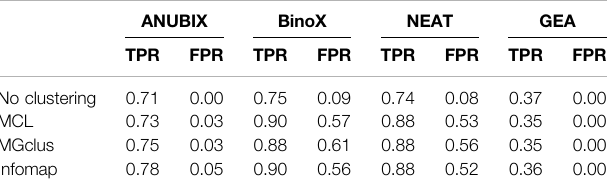
TABLE1| Truepositiverate(TPR)andfalsepositiverate(FPR)forcombinationsof the clustering and pathway enrichment methods run at FDR =